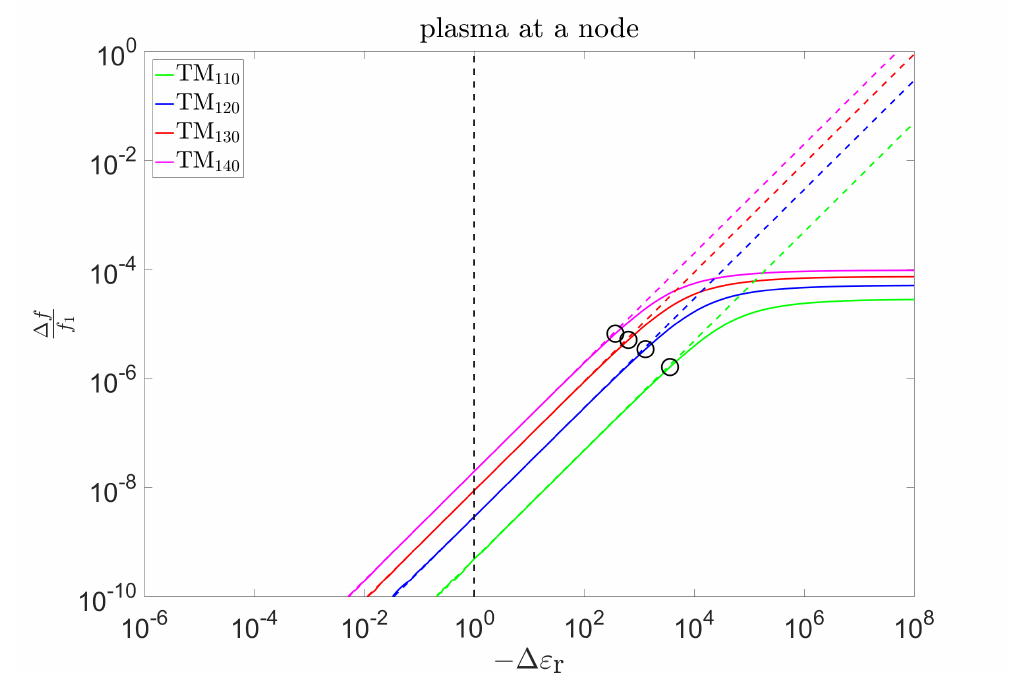
∆ f as a function f 1